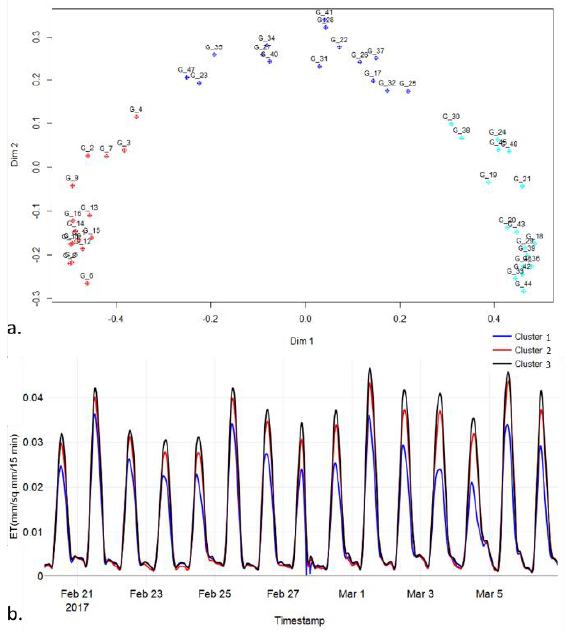
Figure 6. MDS plot genotypic clusters (a) and average ET time series of each cluster (b)